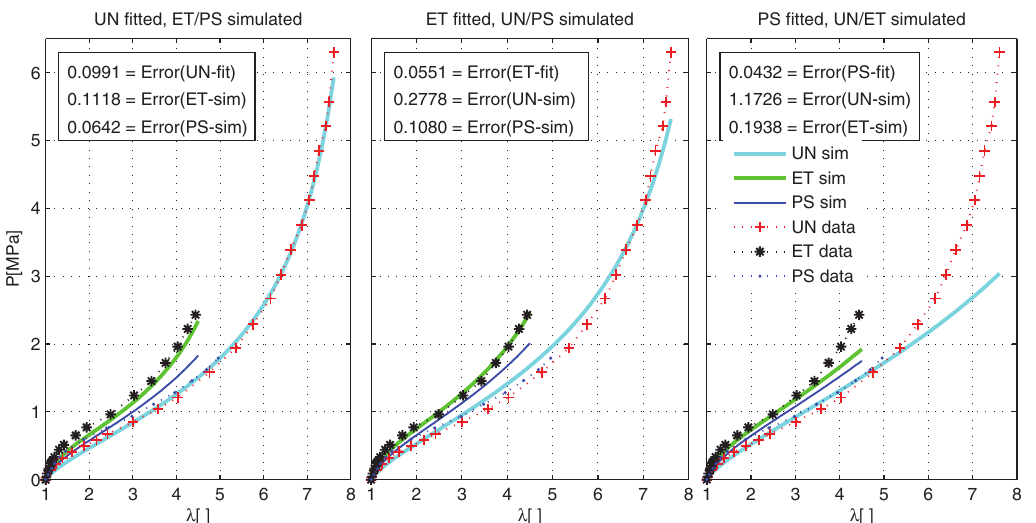
Figure 5: Performance of the bootstrapped eight-chain model on the Treloar data. The fittings and simulations are good to excellent, espe- cially if compared to the similarly structured models, for example, the original eight-chain model or the two-parameter Gent model.